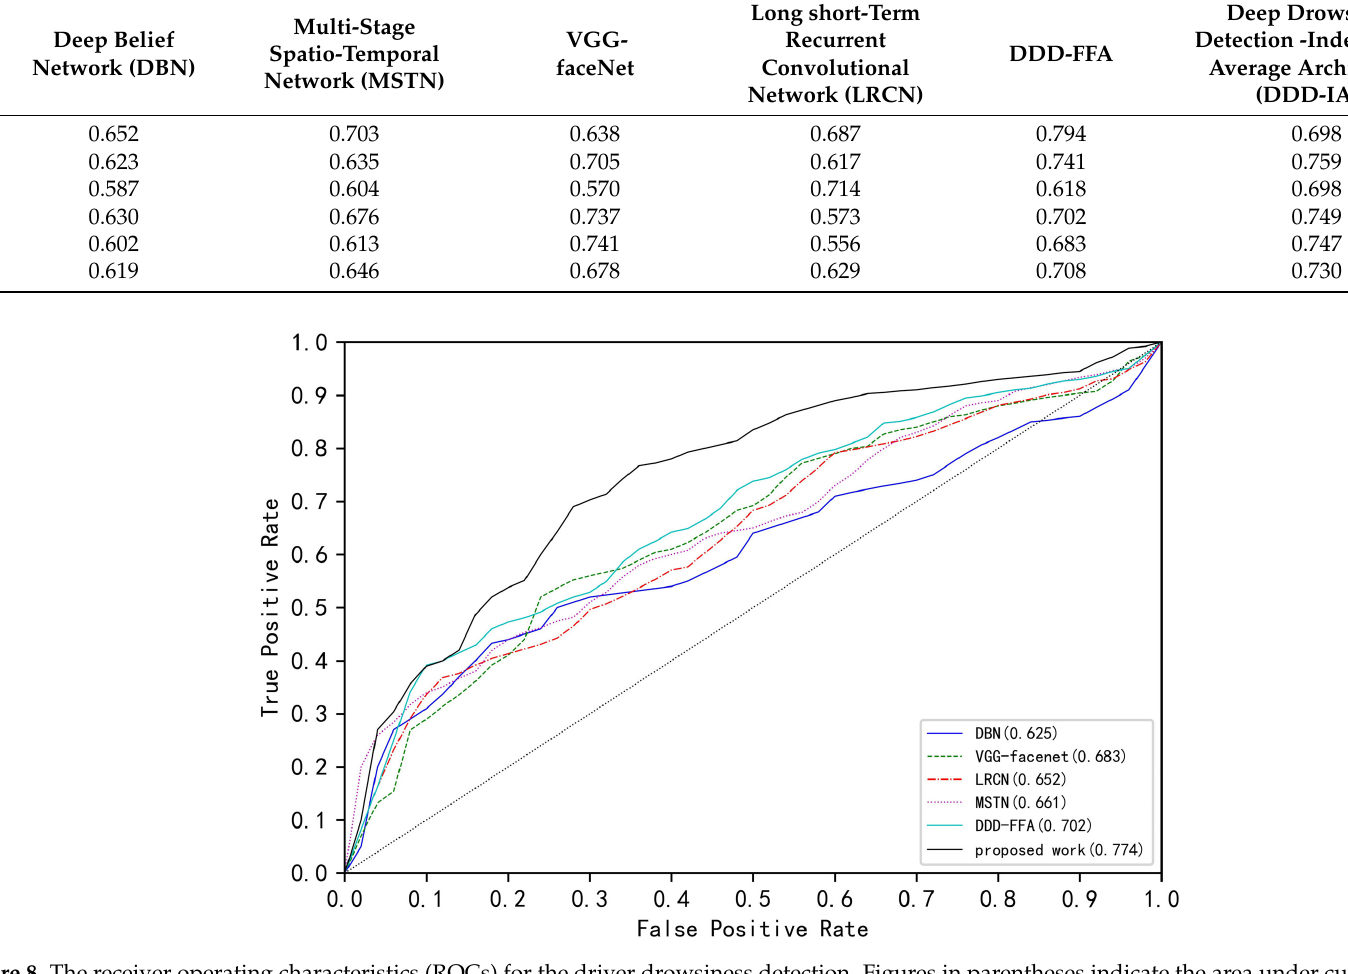
Figure 8. The receiver operating characteristics (ROCs) for the driver drowsiness detection. Figures in parentheses indicate the area under curves (AUCs).